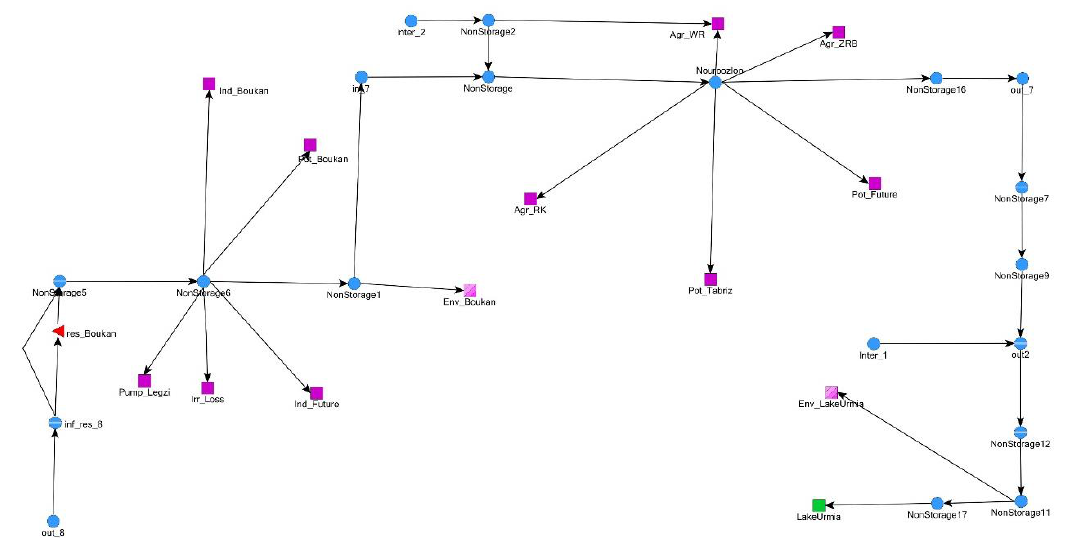
Figure 2. MODSIM conceptualized network system for the Boukan Dam and the ZRB watershed.